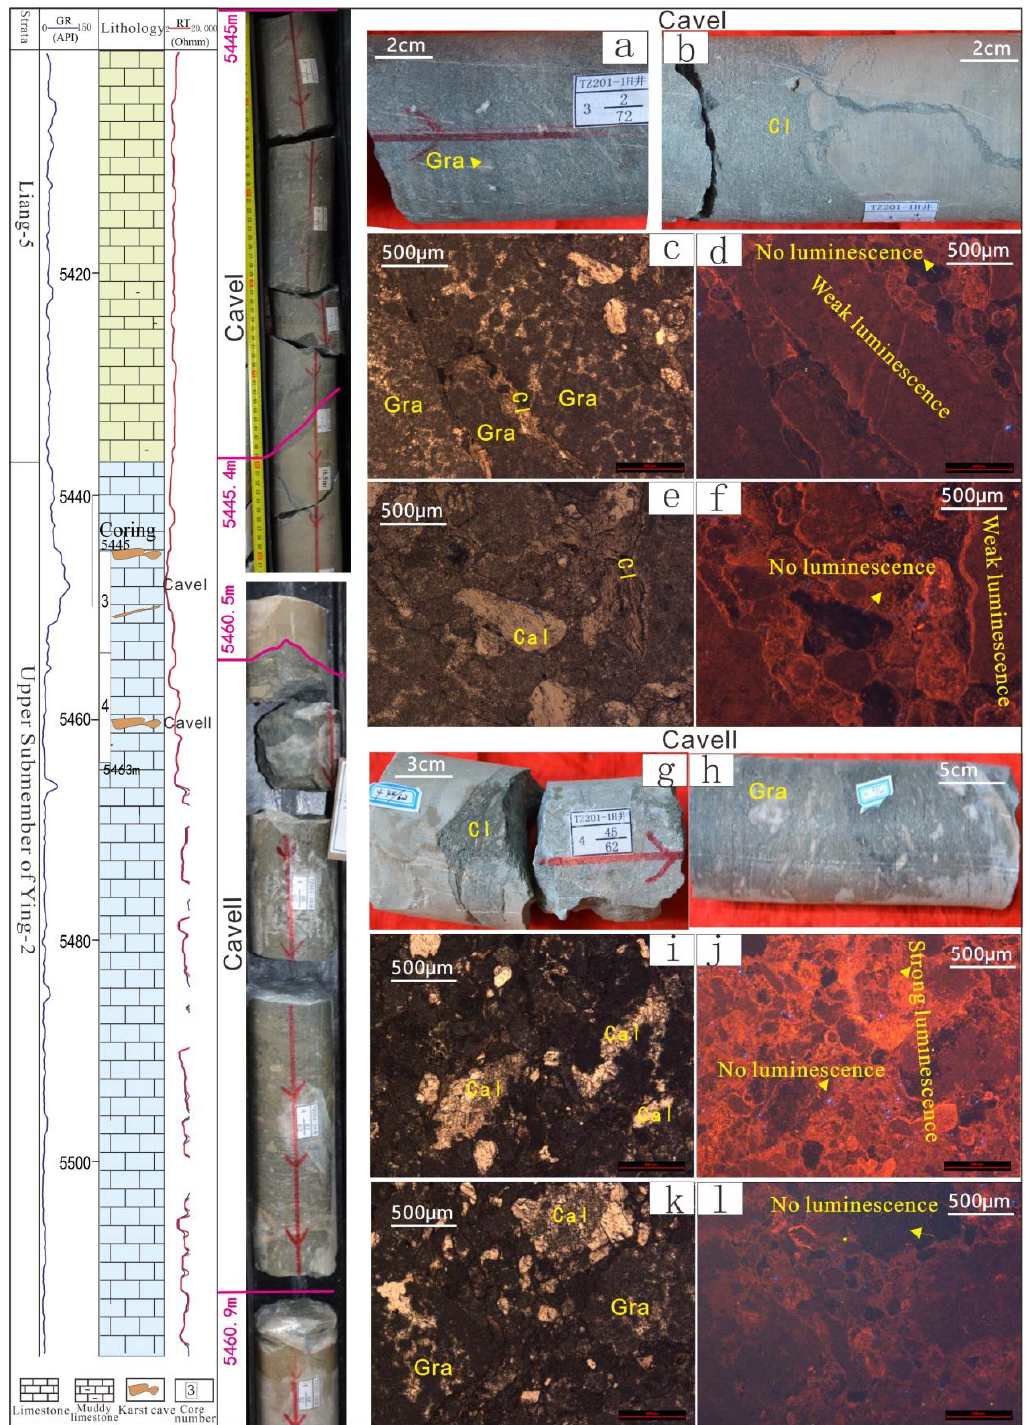
Figure 6. The petrological characteristics of karst pore and cave fillings of the Yingshan Formation in Well TL201-1H. ( a ) Cave I fillings, gravel, clay, fillings cemented compactly; ( b ) boundary between bottom of cave I and limestone; ( c , e ) under the microscope of fillings in cave I, bright crystal sand debris limestone particles, calcite and a small amount of clay can be seen; ( d , f ) under cathodoluminescence, the bright crystal sand ‐ chip limestone particles in the filling weakly glow, and calcite does not glow; ( g , h ) fillings at the top and inside of cave II can be seen in limestone gravel, and the fillings are cemented compactly; ( i , k ) the fillings in cave II (limestone particles, calcite, and a small amount of clay); ( j , l ) under cathodoluminescence, the limestone particles in the fillings are weak–strong luminescence, and the luminescence ring is seen at the edge of the particles, while the calcite does not luminescence.